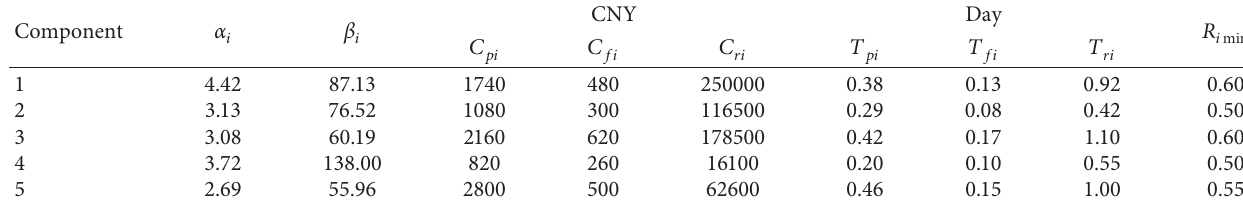
Figure 7: Reliability block diagram of the driving device. Table 1: The values of parameters in the presented numerical